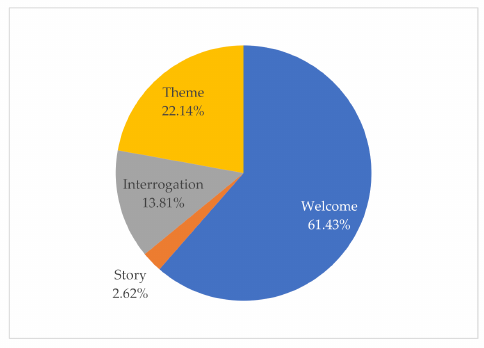
Figure 2. Start-up